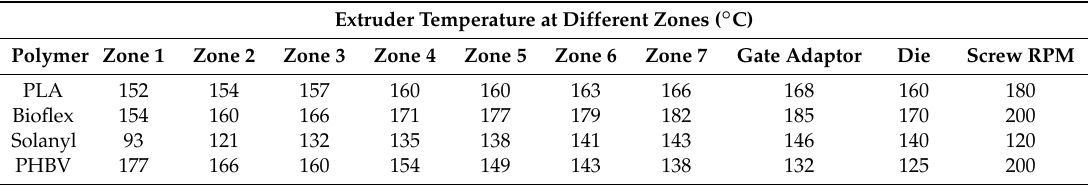
Table 2. Extrusion temperature profiles for each